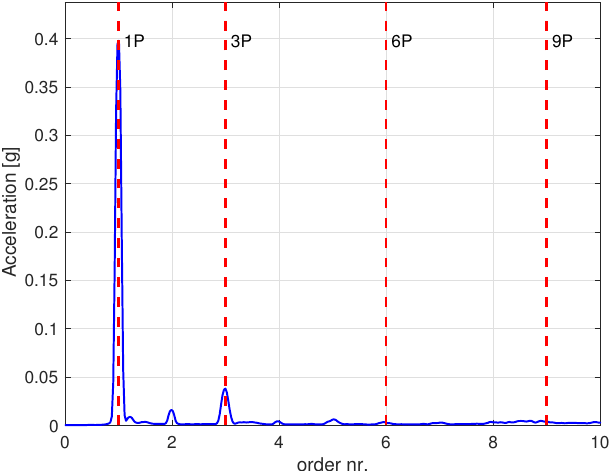
Figure 8. Order spectrum of the experimental Y direction tower